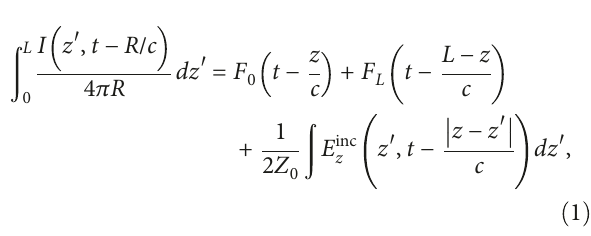
Figure 1: The cylindrical model of the body exposed to transient